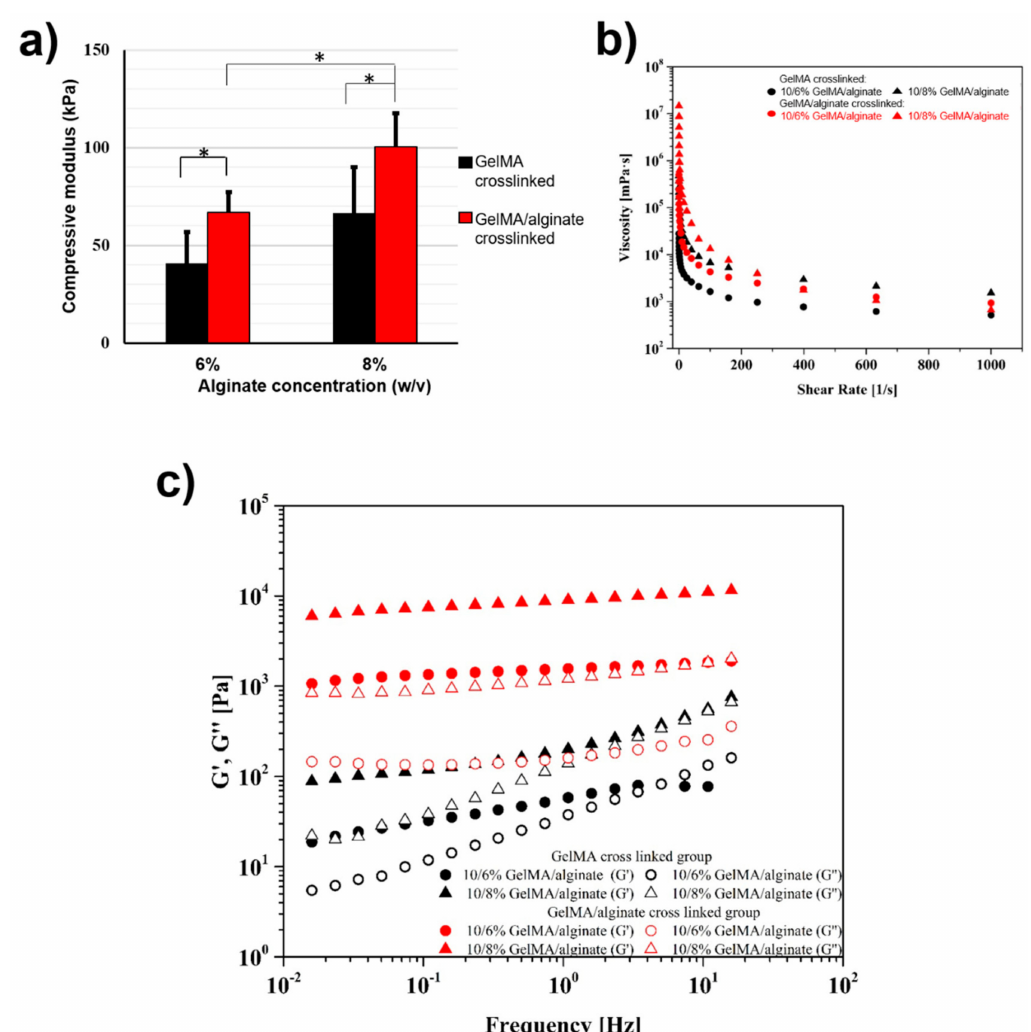
Figure 1. Mechanical and rheological properties of GelMA and GelMA-alginate hydrogels. ( a ) Compressive moduli of 10% (w / v) GelMA with two di ff erent alginate concentrations (6% and 8% (w / v)). Di ff erent colors indicate di ff erent crosslinking methods. Black bars are representative of UV crosslinking method and red bars indicate soaked sample into 0.1 M CaCl 2 bath for 2 min prior to the UV crosslinking (n = 6; * p < 0.05). ( b ) Rheological properties of GelMA and GelMA-alginate hydrogels. Viscosity as a function of shear rate at 27 ◦ C for di ff erent hydrogel samples. ( c ) Storage and loss moduli for underlying